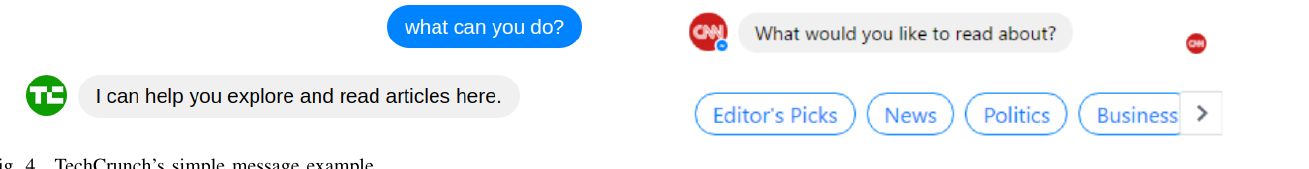
Fig. 6. CNN’s suggestions example.